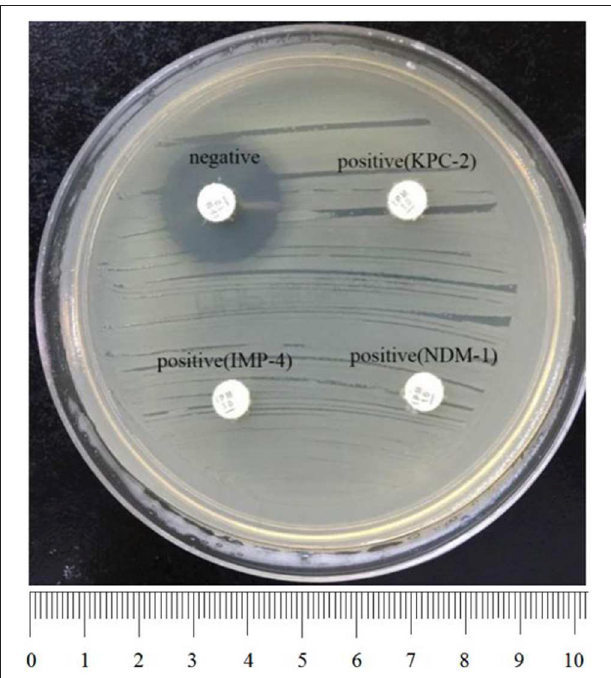
FIGURE 2 | Results of rCDM testing of P. aeruginosa (6h). The zone of inhibition of the negative isolate was 23mm, whereas the zones of inhibition of the positive isolates were 6mm. Upper left , VIM-1-producing P. aeruginosa ; bottom left , VIM-4-producing P. aeruginosa ; bottom right, KPC-2-producing P. aeruginosa .